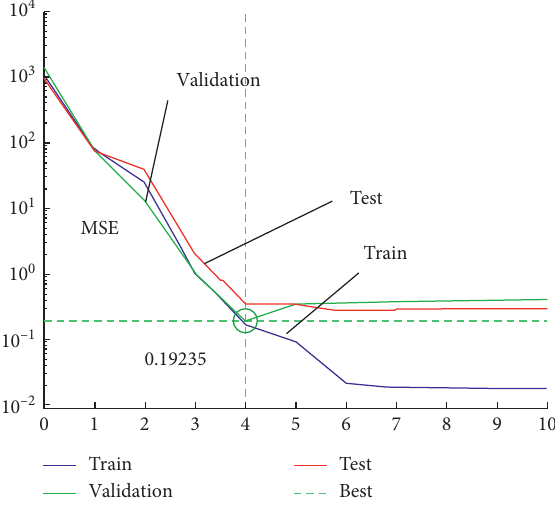
Figure 4: MSE of BP neural network. Table 2: Prediction error analysis of